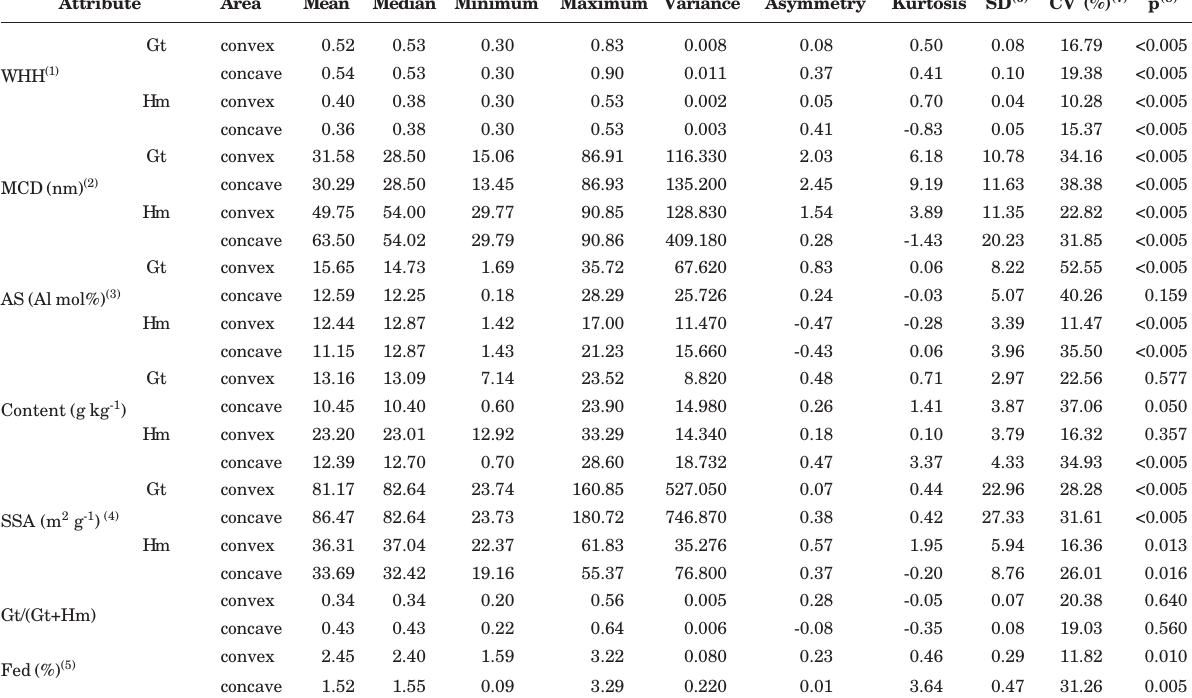
Table 2. Descriptive statistics of the properties of goethite and hematite in the convex and concave area